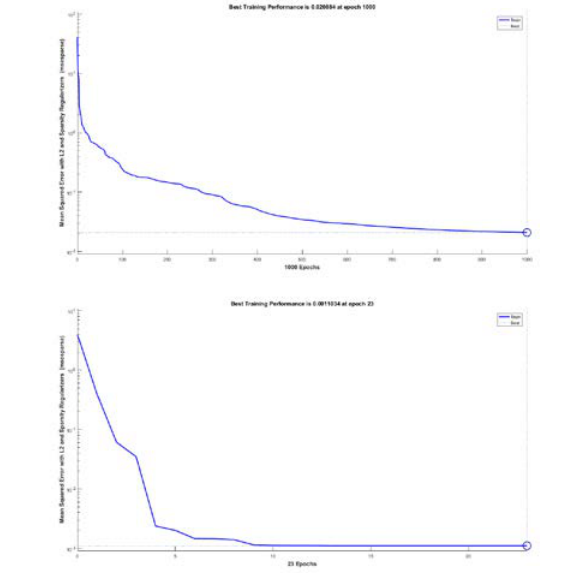
Figure 6. Training performance in terms of Mean Squared Error for autoencoders 1 (Up) and 2 (Down).